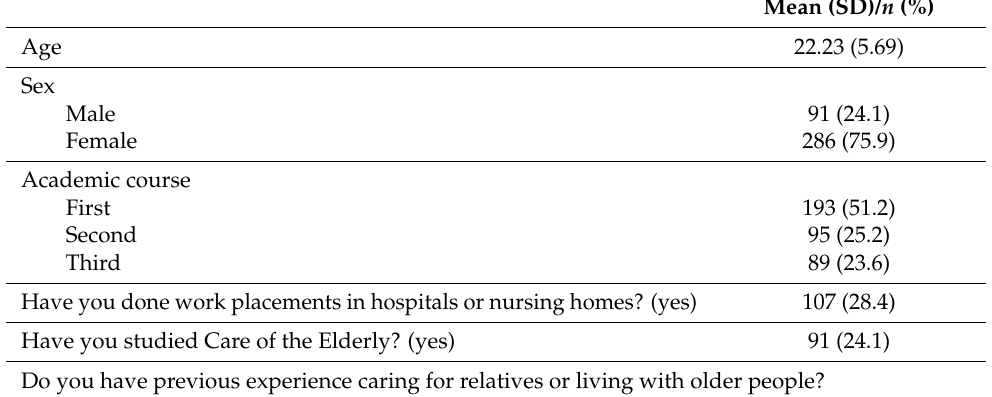
Table 1. Characteristics of the study